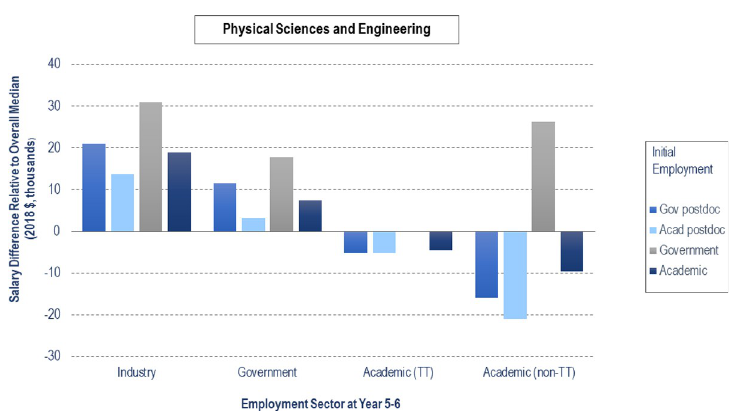
Fig 3. Median salary comparison at Year 5–6 for physical sciences and engineering by initial employment type and sector.